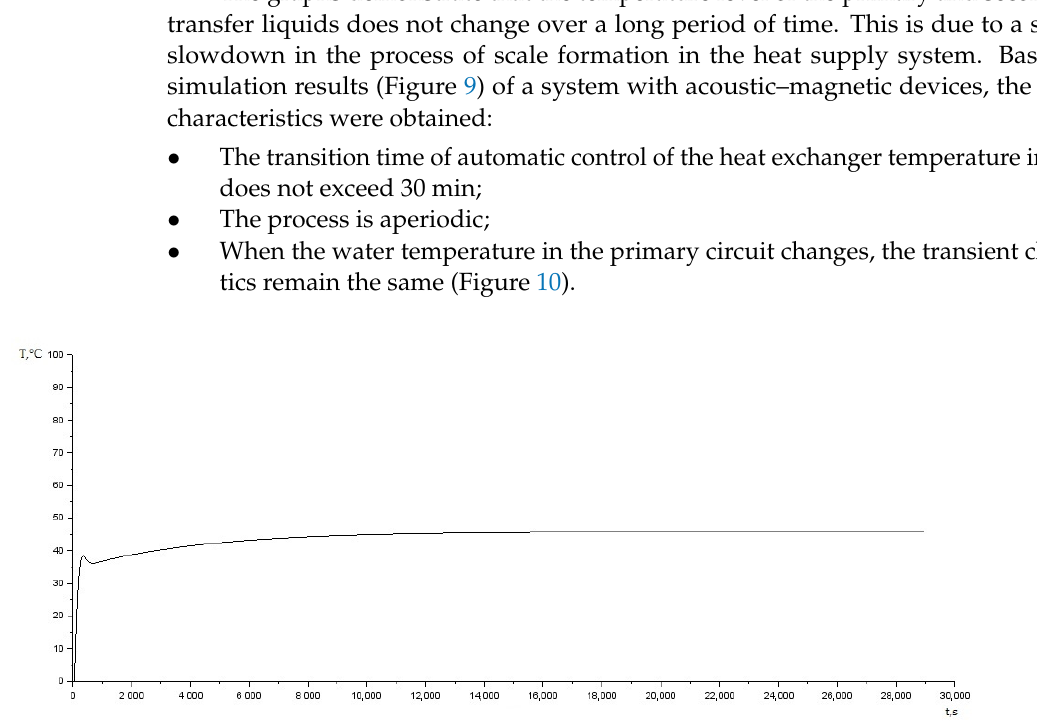
Figure 9. Transient characteristics of the model of the automatic control system of the temperature of the heat carrier with an acoustic–magnetic device.